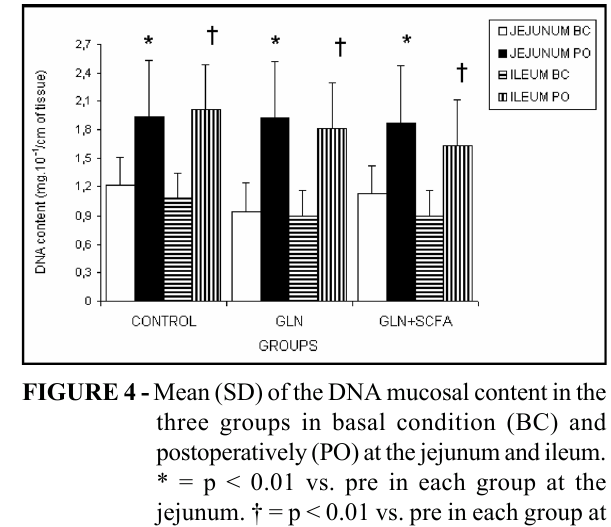
FIGURE 4 - Mean (SD) of the DNA mucosal content in the three groups in basal condition (BC) and postoperatively (PO) at the jejunum and ileum. * = p < 0.01 vs. pre in each group at the jejunum. † = p < 0.01 vs. pre in each group at the ileum. GLN = glutamine group; GLN+SCFA = glutamine+SCFA